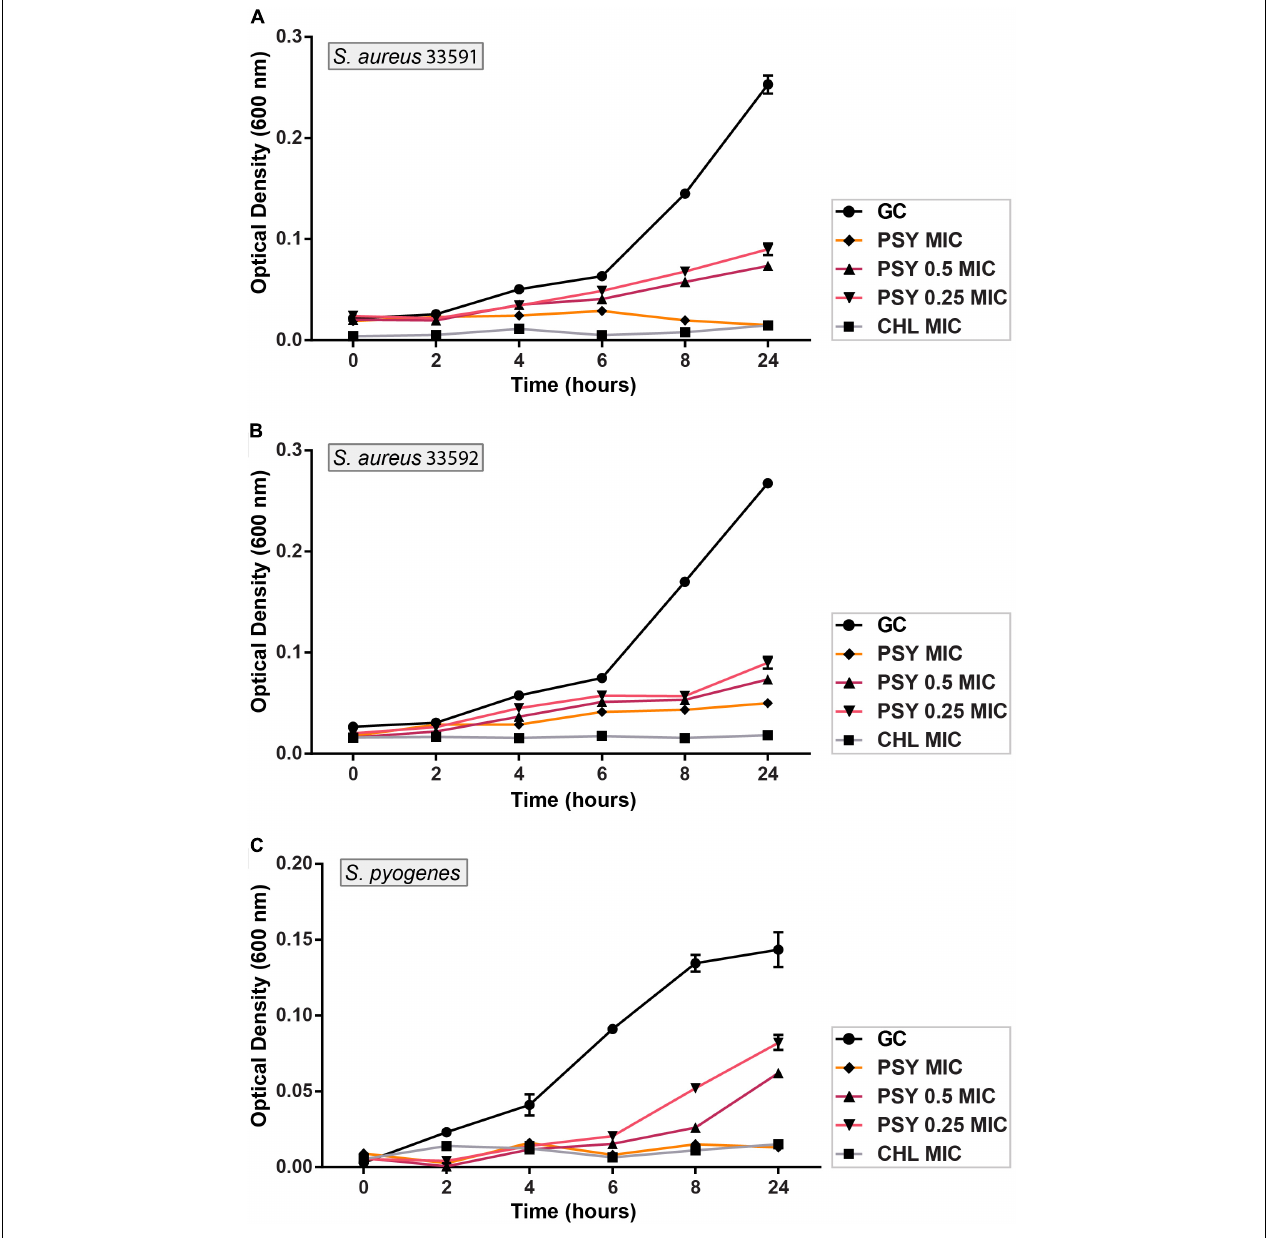
FIGURE 2 | Activity kinetics of psychorubrin (PSY) against S. aureus 33591 (A) ; S. aureus 33592 (B); and S. pyogenes 10096 (C) . Chloramphenicol (CHL) was used as positive control, and bacteria inoculated in MHB with psychorubrin vehicle was used as bacteria growth control (GC). The experiments were carried out in triplicate, and data represent the mean ±